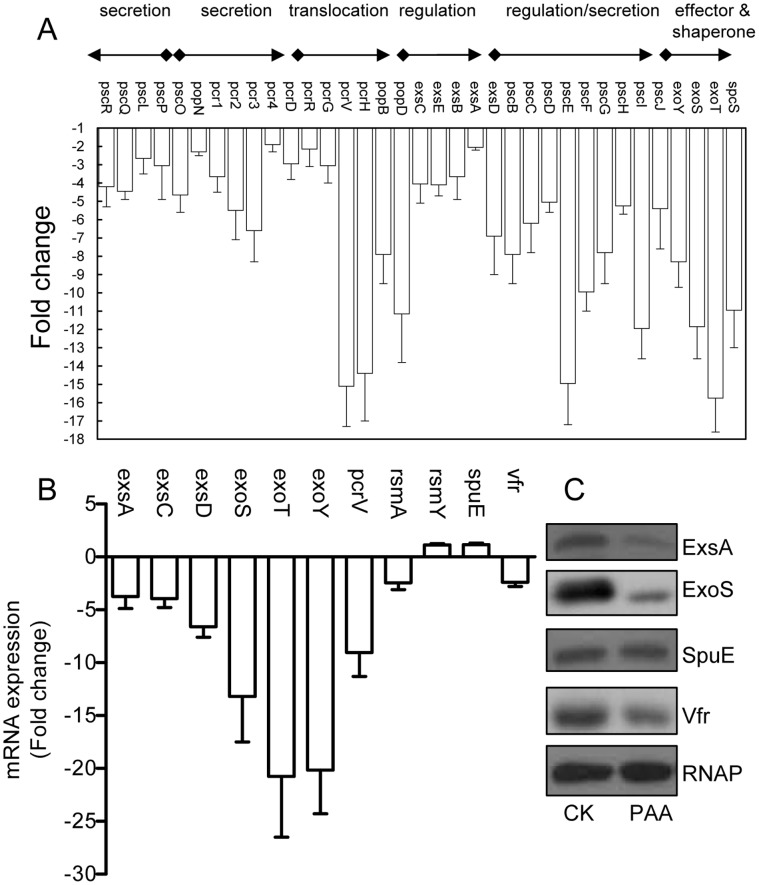
Effect of PAA on bacterial T3SS.(A) The transcriptional changes of T3SS genes in strain PAO1 treated with exogenous PAA compared to untreated PAO1. The experiment was repeated for two times. (B) Real-time PCR measurements of the mRNA levels of T3SS-related genes after treated with 1 mM PAA compared to the control without treatment. (C) Immunoblotting detection of T3SS-related proteins. Bacterial cultures were grown in LB medium supplemented with NTA as indicated. The extra-cellular proteins (ECP) and intra-cellular proteins (ICP) from strains PAO1 were separated by 10% SDS-PAGE. The proteins were transferred onto nitrocellulose membrane and blotted with antibodies.